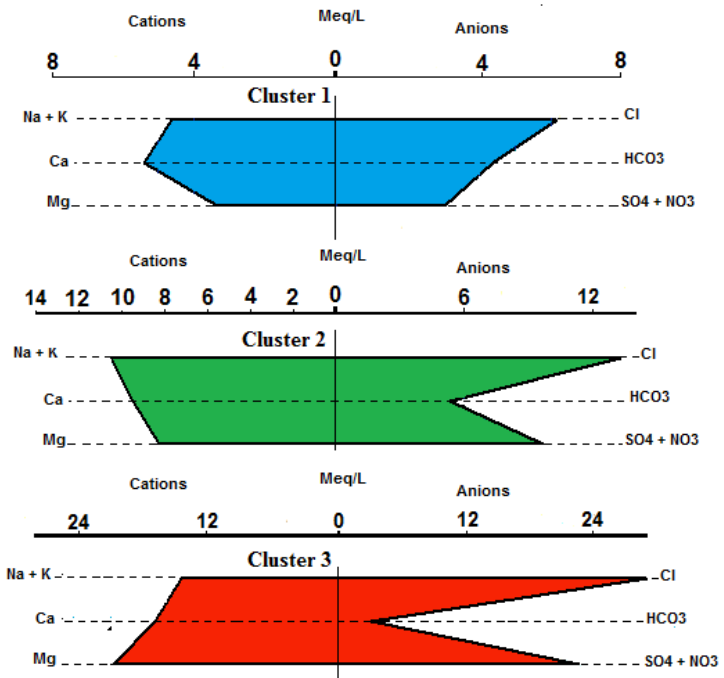
Figure 4. Stiff diagram for three water clusters.